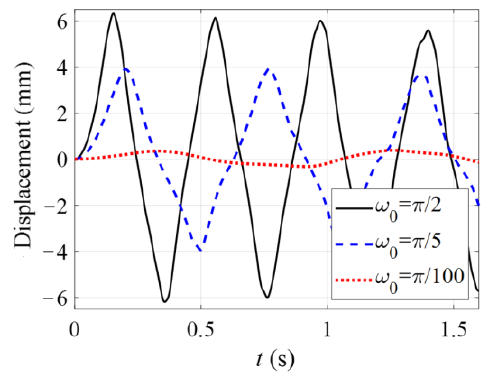
Figure 10. Time histories of point A of M1, T = 0.1 s. Table 8. Dynamic responses of point A of M1, T = 0.1 s.